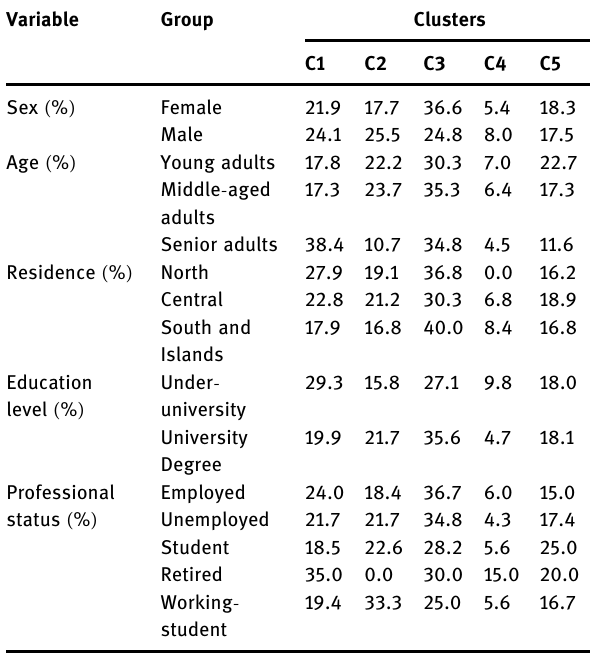
Table 3: Sociodemographic characterization of the clusters